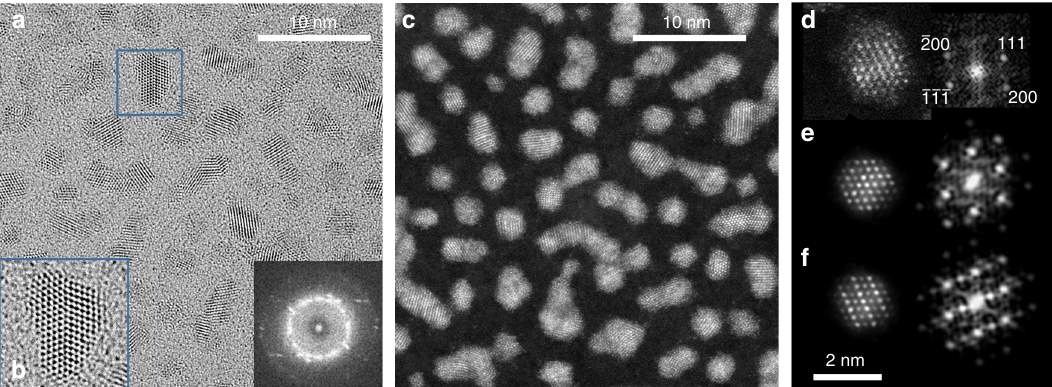
Fig. 1 As-grown room temperature AgPt sample ( fl ux 3.2 × 10 15 at cm − 2 ). a HRTEM images and in the inset, the total Fourier transform. b Zoom (×2) showing crystal twinning. c STEM-HAADF image with homogeneous contrast. High-resolution STEM-HAADF image and the corresponding FFT for d experimental NP along the [01 (cid:1) 1] zone axis and the corresponding simulated images e for a random solid solution and f for an L1 1 ordered structure. HRTEM high resolution in TEM, STEM-HAADF high angle annular dark fi eld in scanning transmission electron microscope, NP